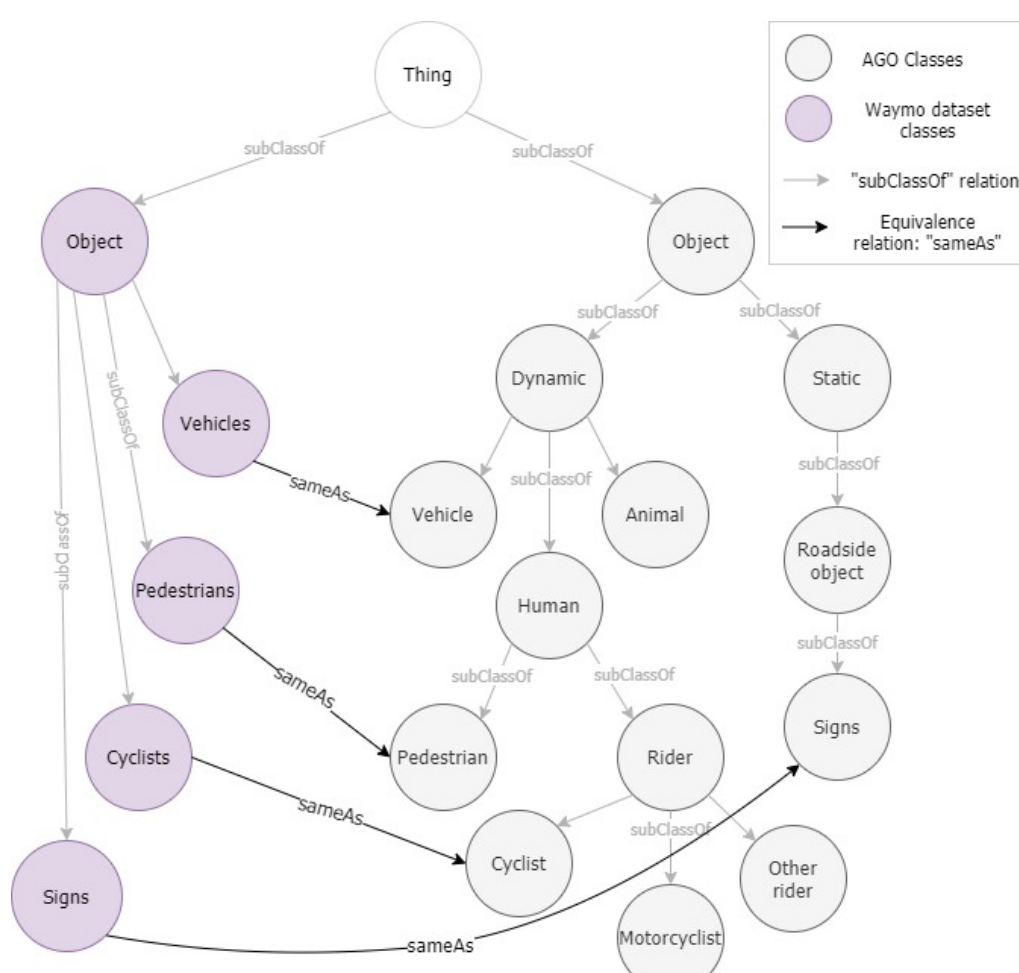
Figure 8. Waymo dataset mapping to AGO example. Matched classes represent the common terms among the different datasets and, thus, the translation can be undertaken by identifying these equivalences.